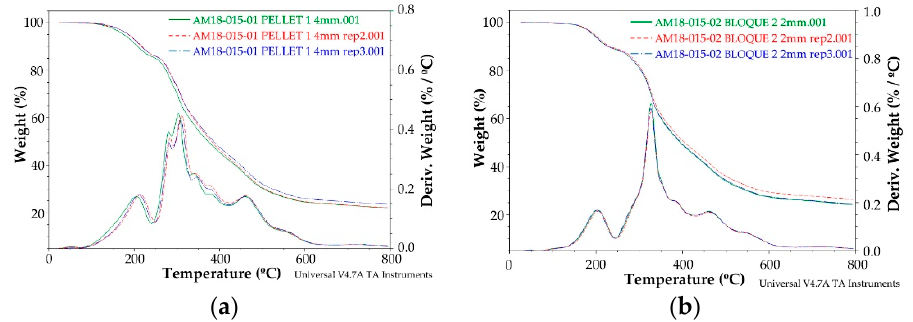
Figure 3. ( a ) TGA of the polyurethanes (P) and ( b ) polyurethanes (B) that come from the insulation industry for refrigeration from the Paneles Aislantes Peninsulares (PAP) Factory.